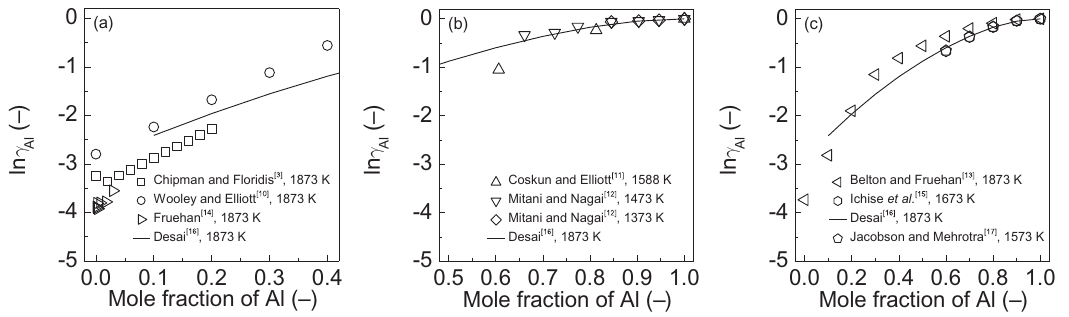
0.0 of Al relative to pure liquid Al(l) as standard state for three categories of Figure 1: Comparison among reported activity coefficient ln γ Al Fe – Al binary melts (a, b, c) with different ranges of mole fraction x Al of Al at various temperatures greater than 1373 K